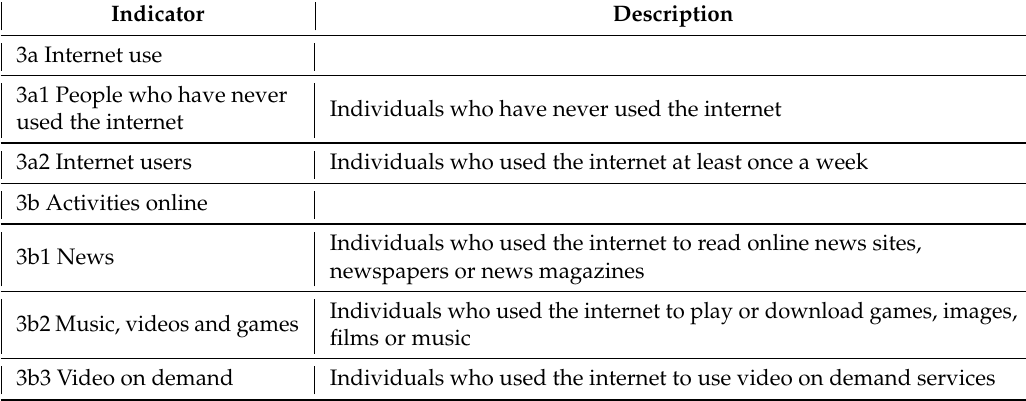
Table 3. The Use of an Internet Services Dimension in the DESI structure. Indicator